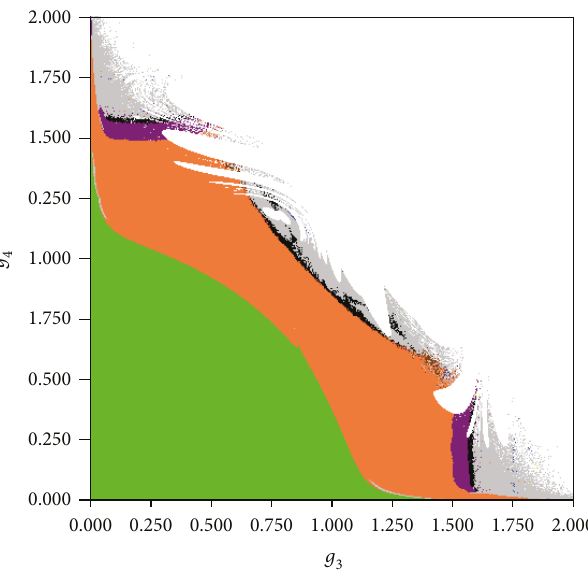
Figure 3: The 2D stable region of g